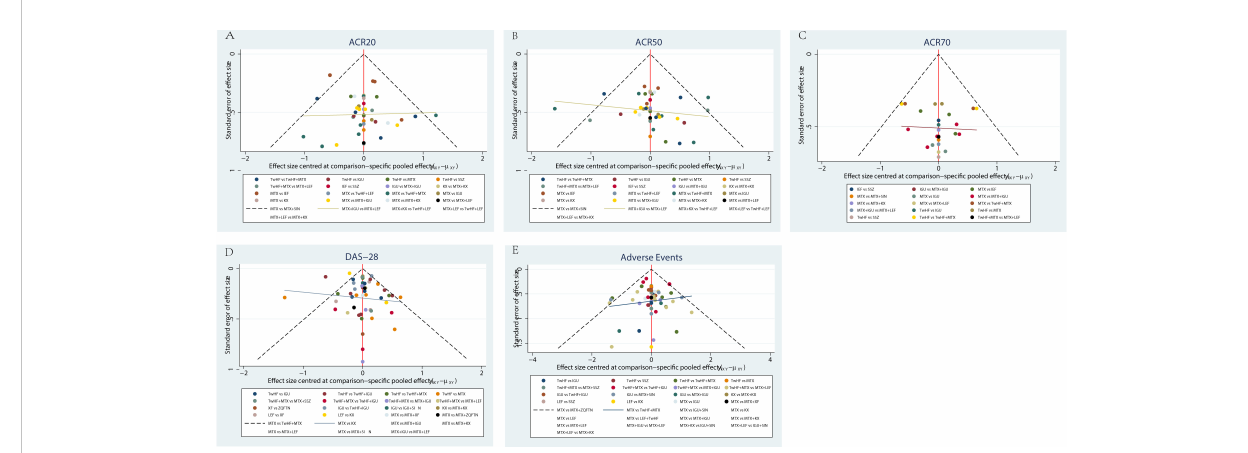
FIGURE 6 Funnel plot. (A) ACR20; (B) ACR50; (C) ACR70; (D) DAS-28; (E) Adverse